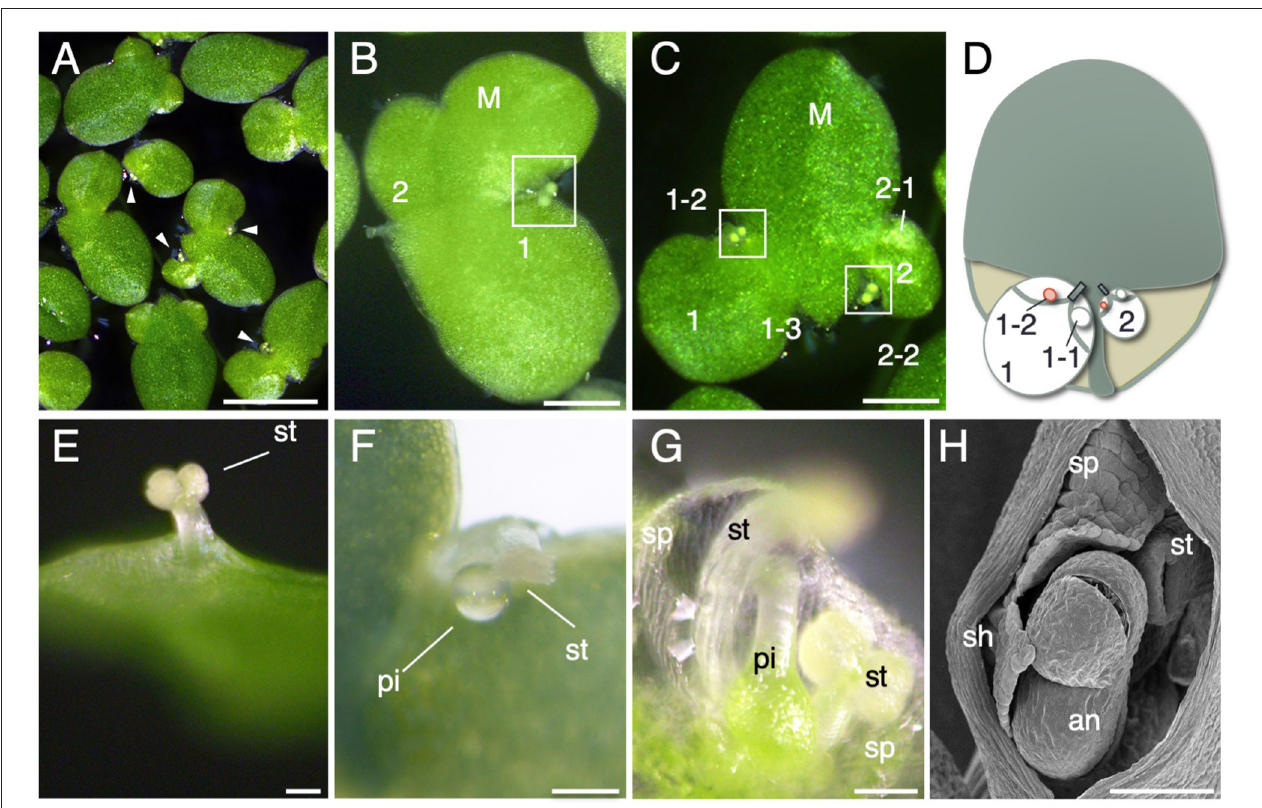
FIGURE 2 | Flower development. (A) Flowering L. aequinoctialis in culture. Arrowheads indicate flowers. (B) Close-up view of a flowering frond. Two flowers are visible. The mother frond (M) produced two daughter fronds: a larger frond (1) and a smaller frond (2). The white rectangle indicates a flower of the larger frond (1). (C) Flower formation in daughter fronds. The mother frond (M) produced two daughter fronds: a larger frond (1) and a smaller frond (2). Daughter frond 1 has two budding pouches, one of which produced a granddaughter frond (1–3), and the other budding pouch produced a flower (1–2 with white rectangle). The first granddaughter frond, named 1–1, has already detached, and the picture shows 1–3, the frond that this pouch formed after 1–1. Daughter frond 2 also produced a granddaughter frond (2–1) and a flower (2–2 enclosed with a white rectangle). (D) Schematic diagram of (C) . (E–G) Close-up view of floral organs. an: anther, st: stamen, pi: pistil, sp: spathe. (H) Scanning electron micrograph of a flower. Scale bars: 1cm (A) , 1mm (B) , and 100 µ m (C–H)